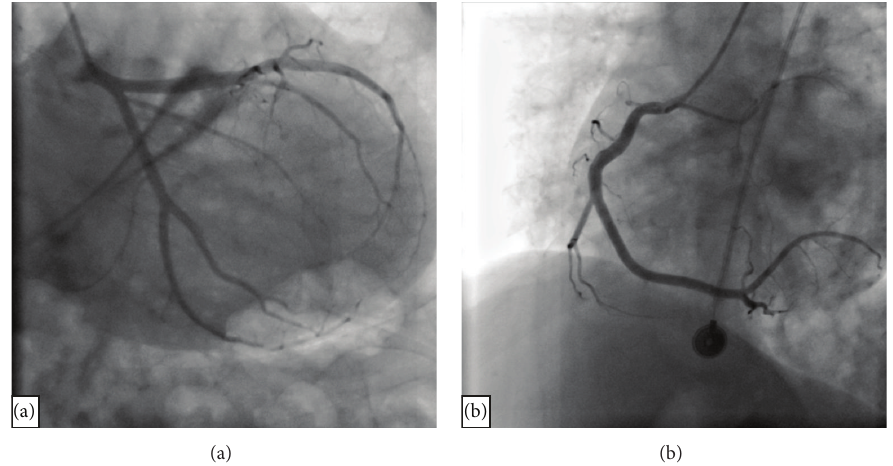
Figure 2: Normal appearance of coronary arteries: (a) left coronary artery system: left anterior descending artery and circumflex, (b) right coronary